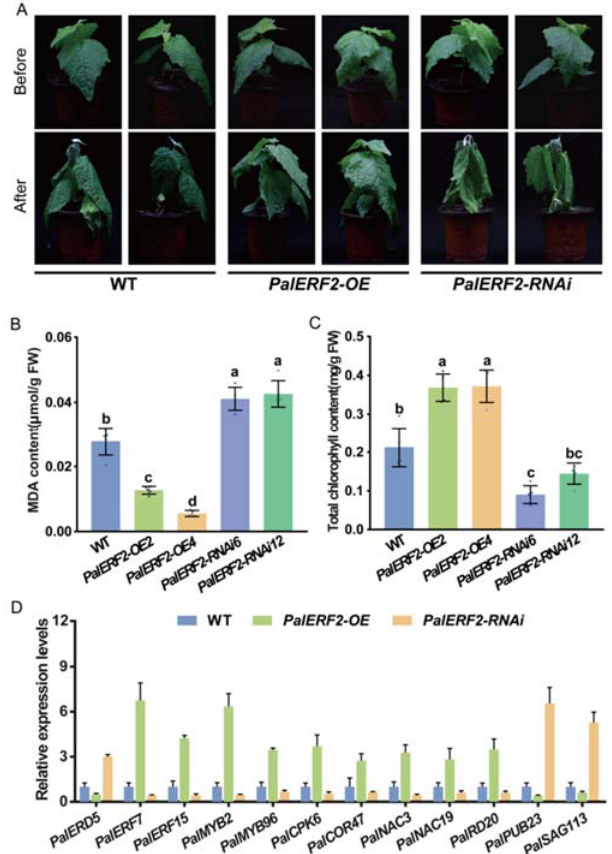
Figure 4. The phenotypes of PalERF2 transgenic poplars under drought stress. ( A ) The phenotypes of transgenic and WT poplars after 5 days of drought treatment. ( B ) The MDA contents were measured after drought treatment. ( C ) The total chlorophyll contents were measured after drought